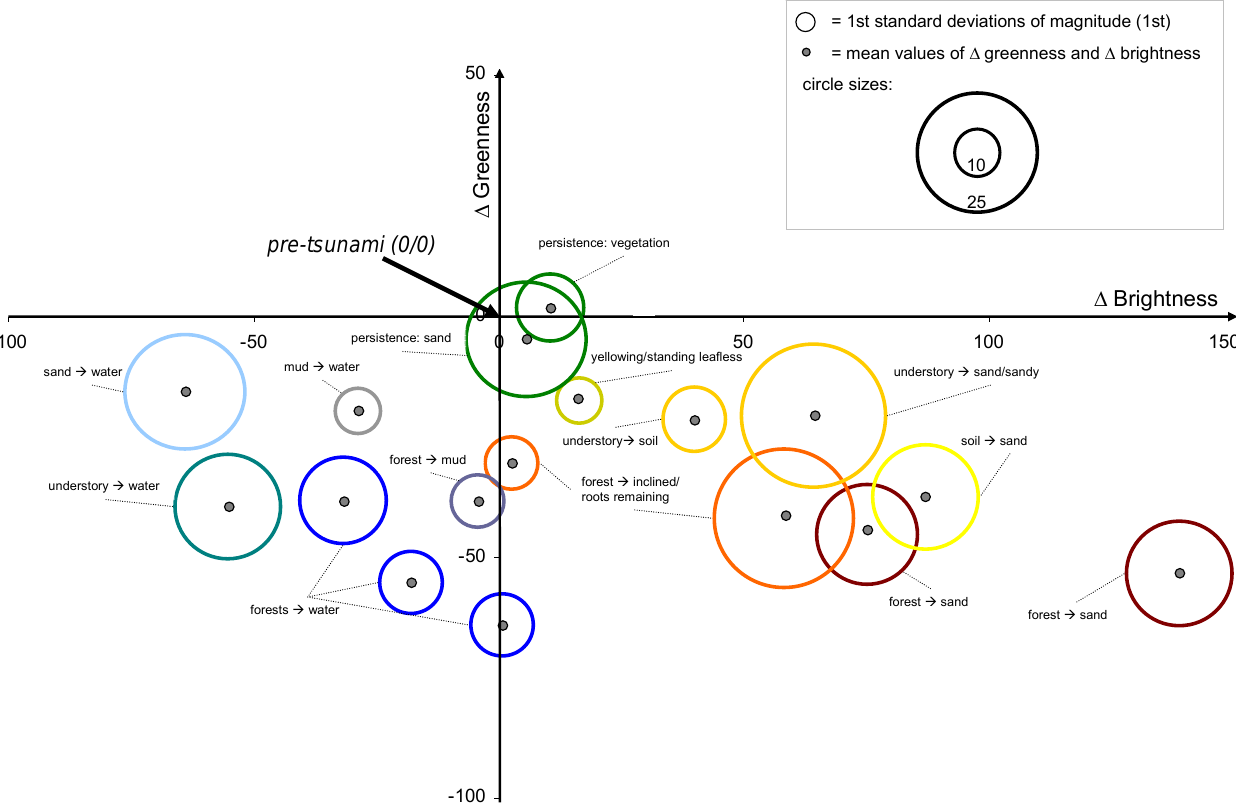
Fig. 7. Training classes from DMC displayed in a two dimensional feature space. Table 5. Damage statistics (area in %) based on